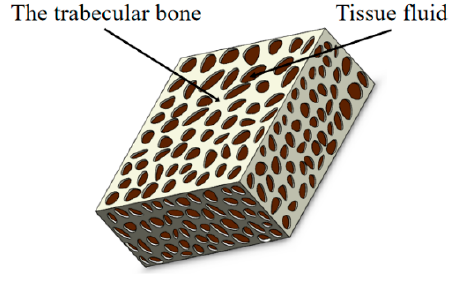
Figure 5. CBAB model.